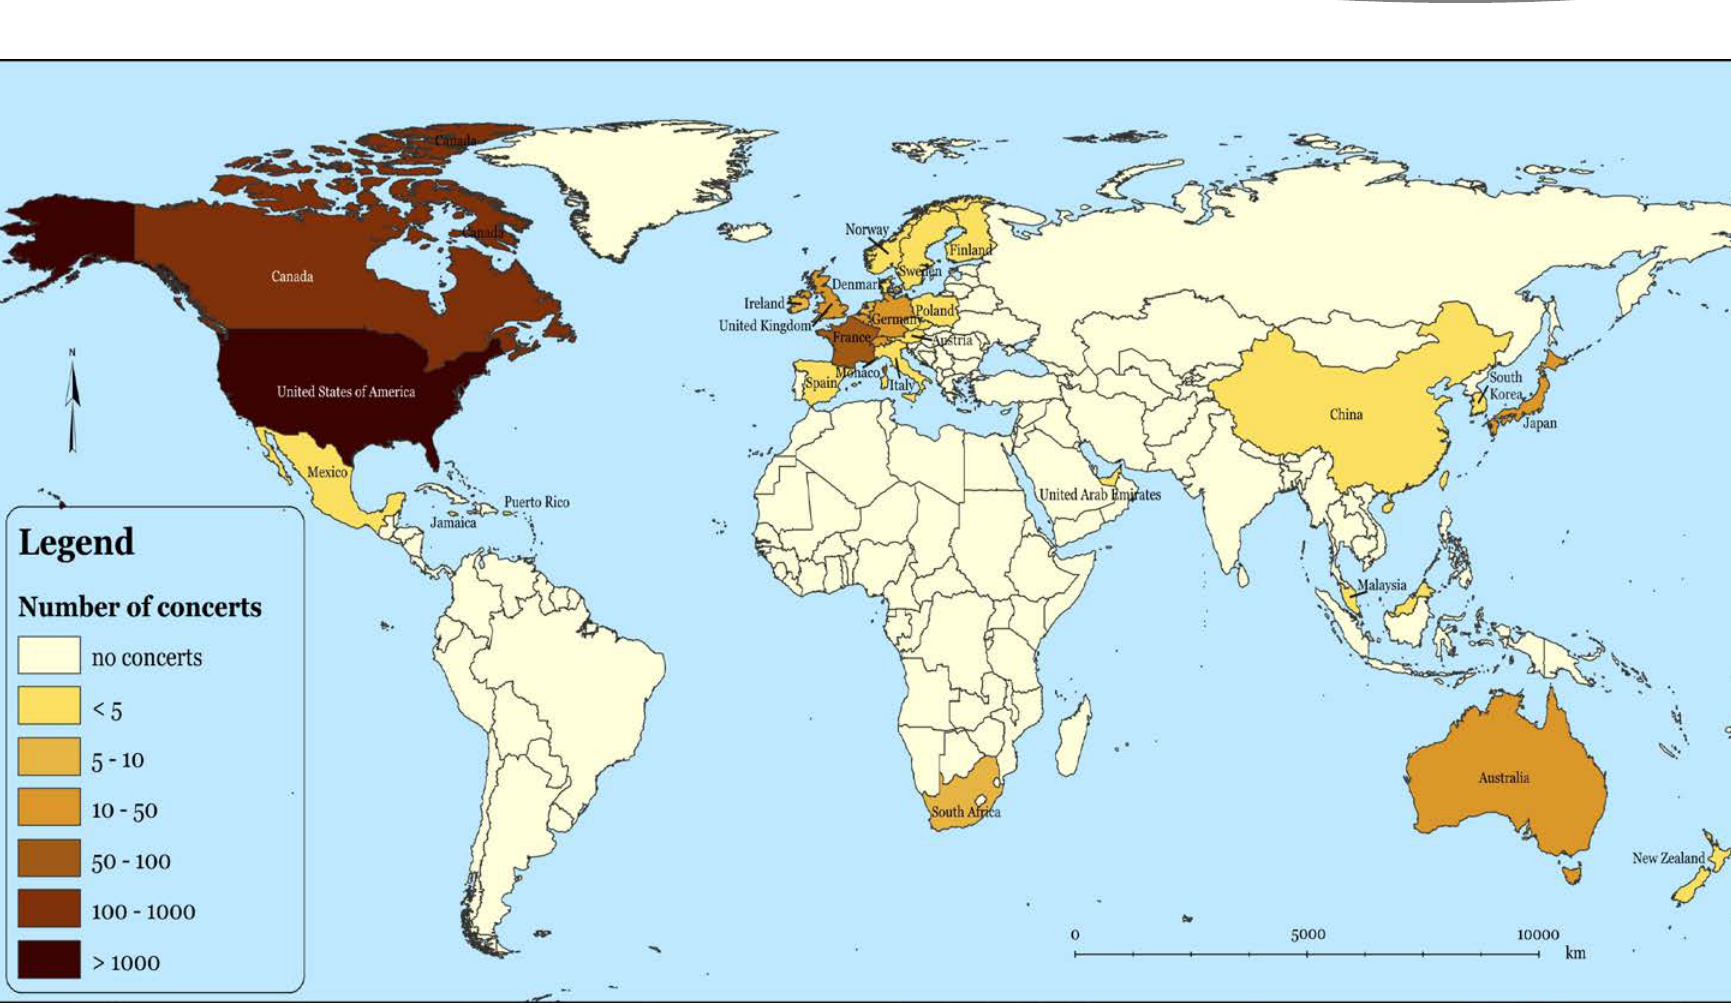
Figure 4: The spatial distribution of Dion’s concerts in the world (1984 –